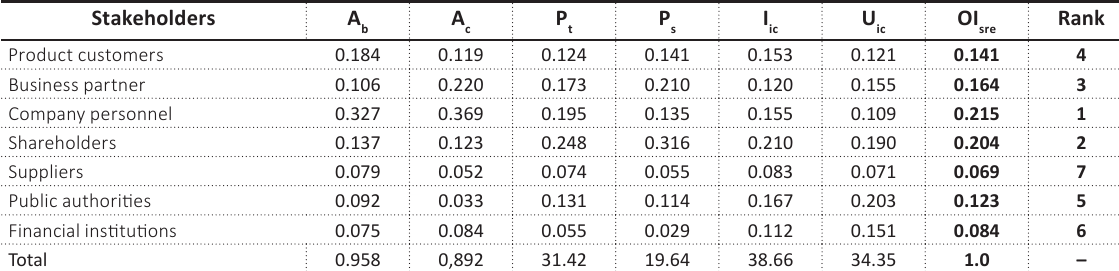
Source: Developed by the